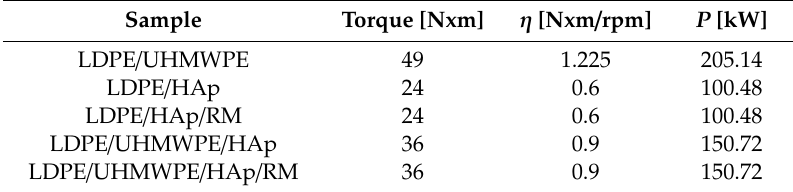
Table 2. Melt processing parameters for LDPE composites evaluated from torque–time Brabender